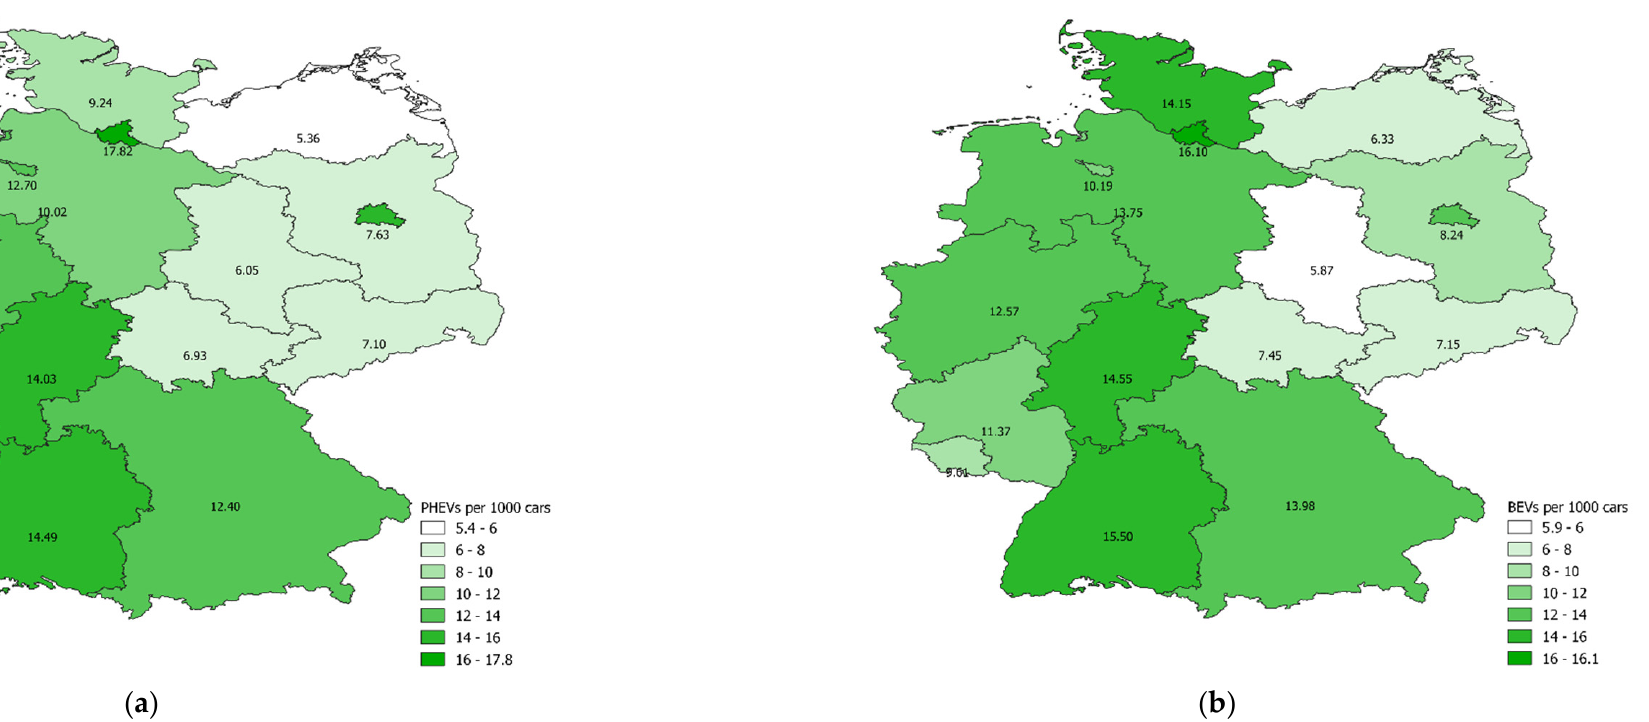
Figure A2. Number of ( a ) PHEVs and ( b ) BEVs per 1000 cars registered by state. Values for Berlin are not shown (14.09 in ( a ) and 13.45 in ( b )) for visual clarity.